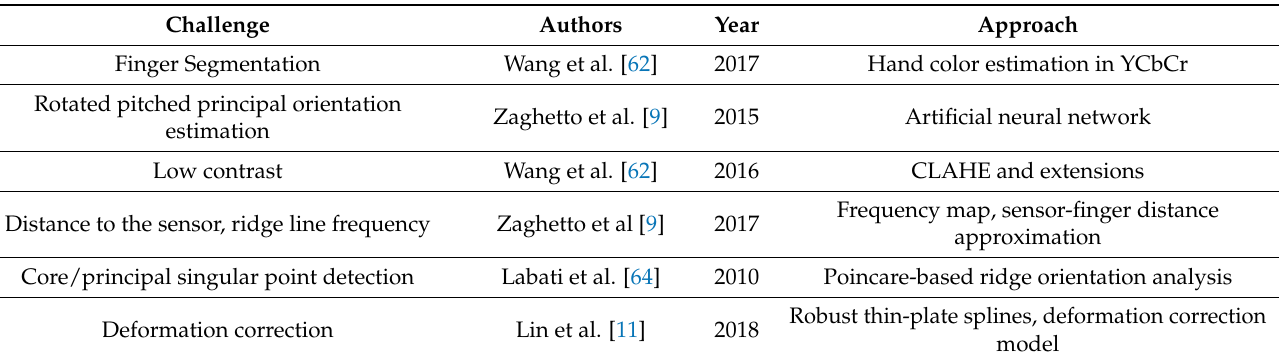
Table 3. Overview of challenges during the preprocessing of contactless finger images and pro- posed